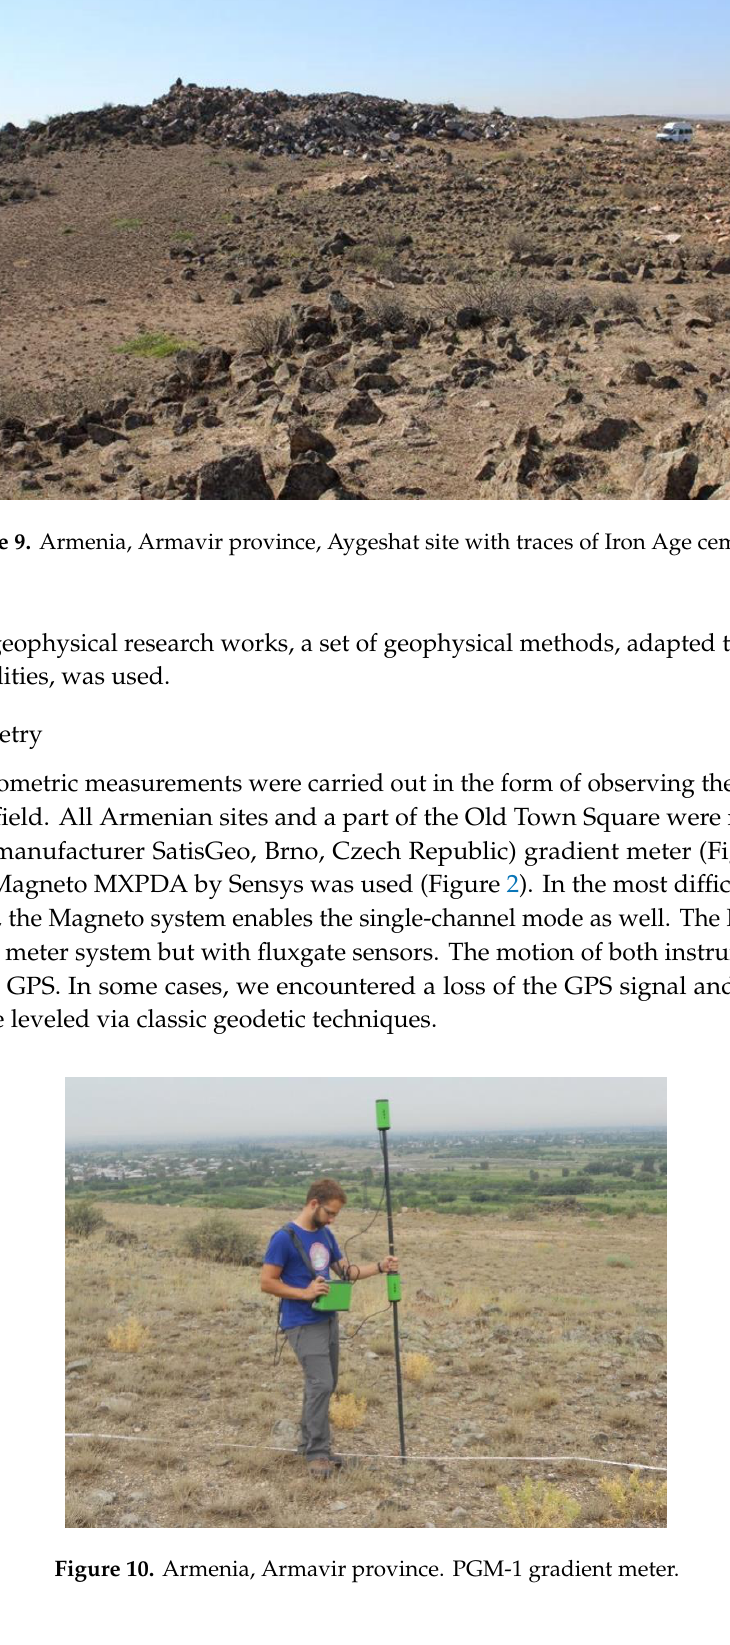
Figure 8. Map of Armenia, Armavir province.